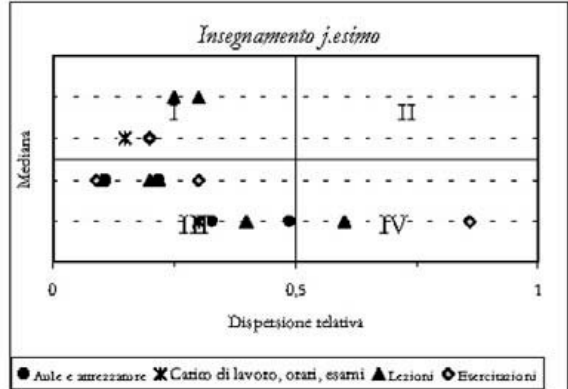
Figura 2 – Rappresentazione grafica della valutazione dell’insegnamento j -esimo - Valore mediano e indice relativo di dispersione per tutti i 17 item